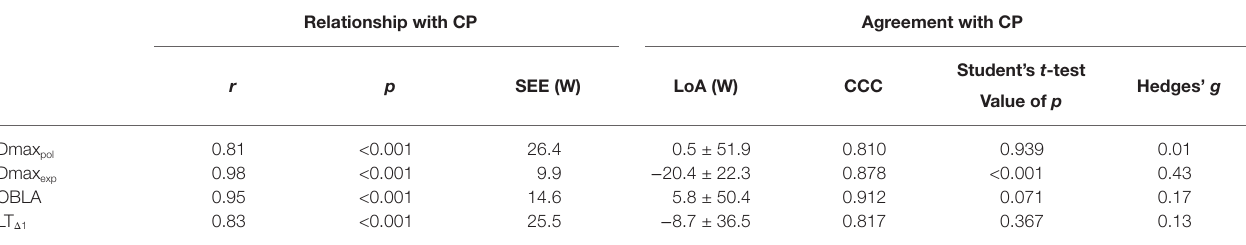
TABLE 2 | Relationship and agreement between the power output corresponding to different lactate threshold markers and critical power. Relationship with CP Agreement with